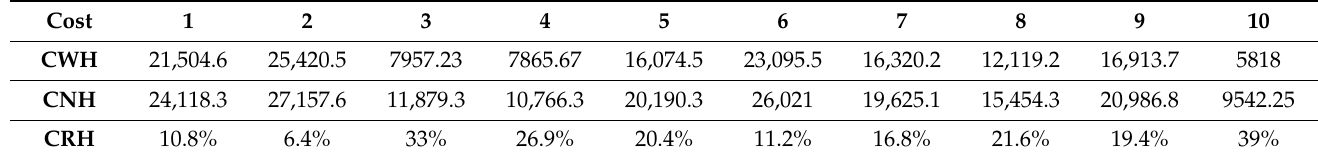
Table 6. Computational results of the second instances set in Case 3.